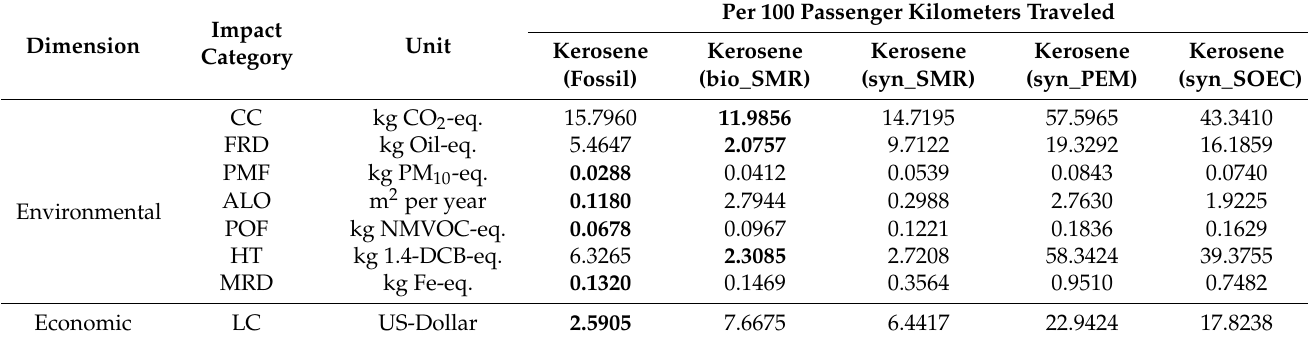
Table 3. Environmental and economic assessment results of the aviation fuels used for flight operation regarding the functional unit of 100 pkm